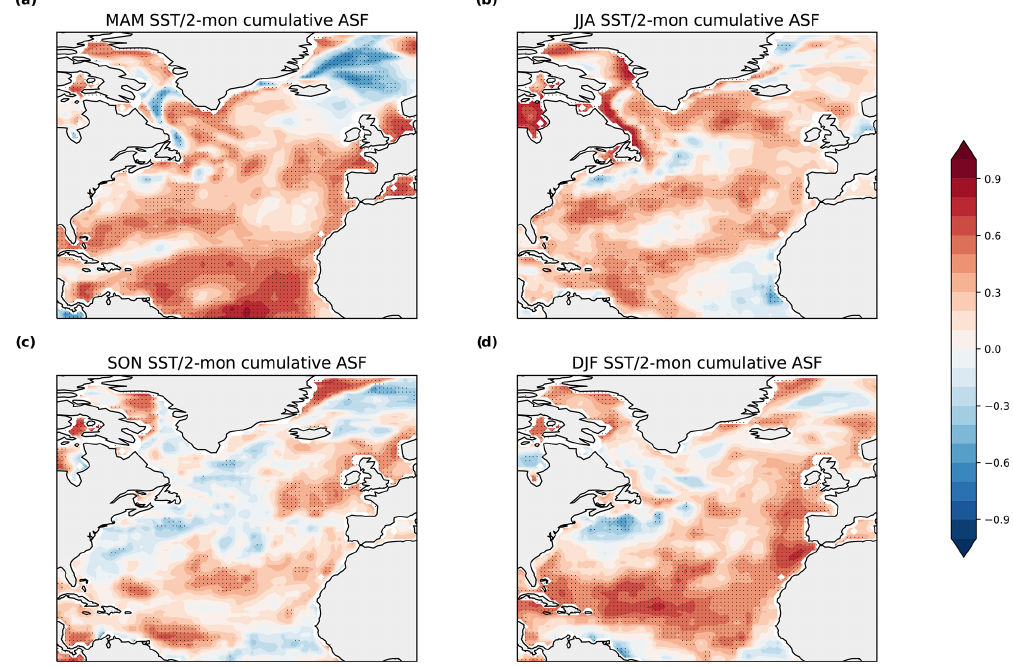
Figure 6. Correlations between the 2-month cumulative ASFs and SSTAs in spring (a) , summer (b) , autumn (c) and winter (d) in the assimilation experiment. As an example, in (a) January and February ASF anomalies are correlated to MAM SSTAs. The stippling represents significant correlations at the 95% confidence level, calculated from 1000 bootstrap